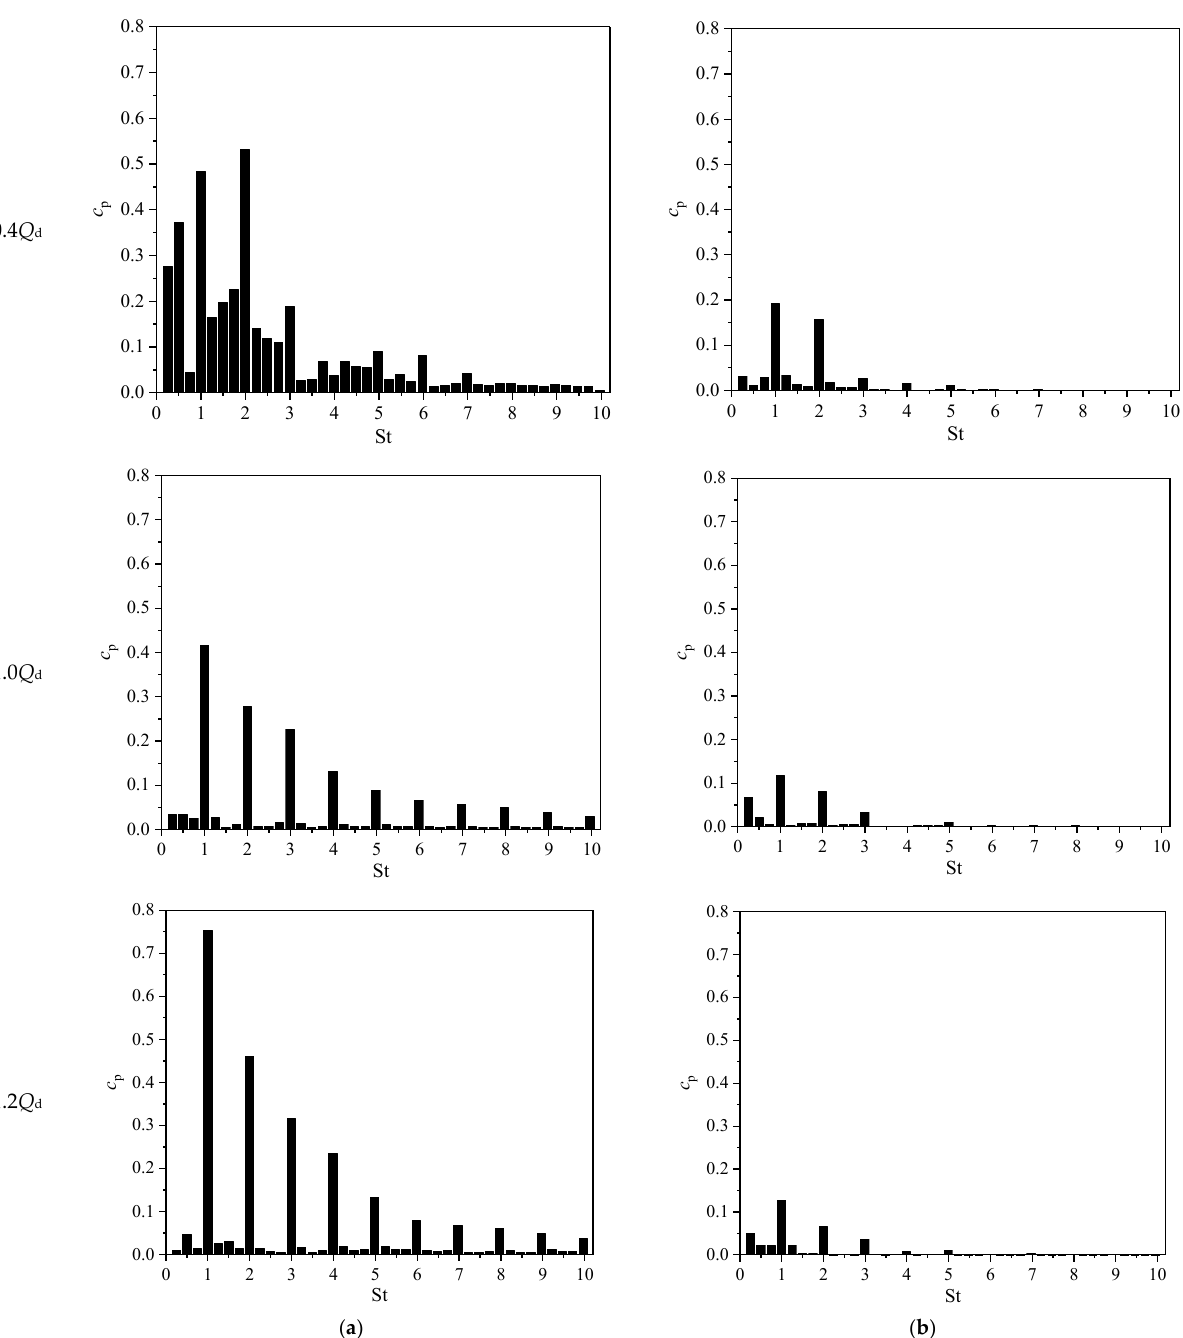
Figure 10. Frequency spectra of pressure pulsations of volute under different flow rates: ( a ) P2; ( b ) P7.